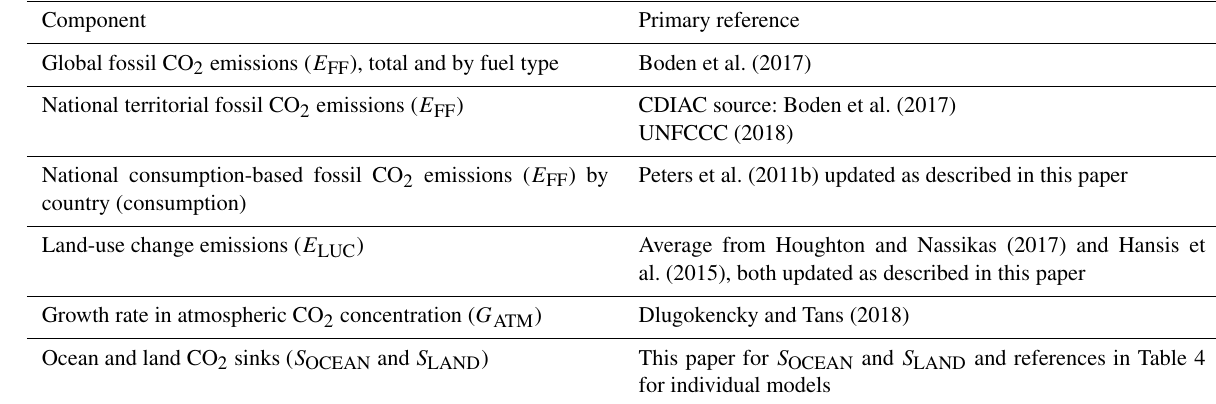
Table 2. How to cite the individual components of the global carbon budget presented